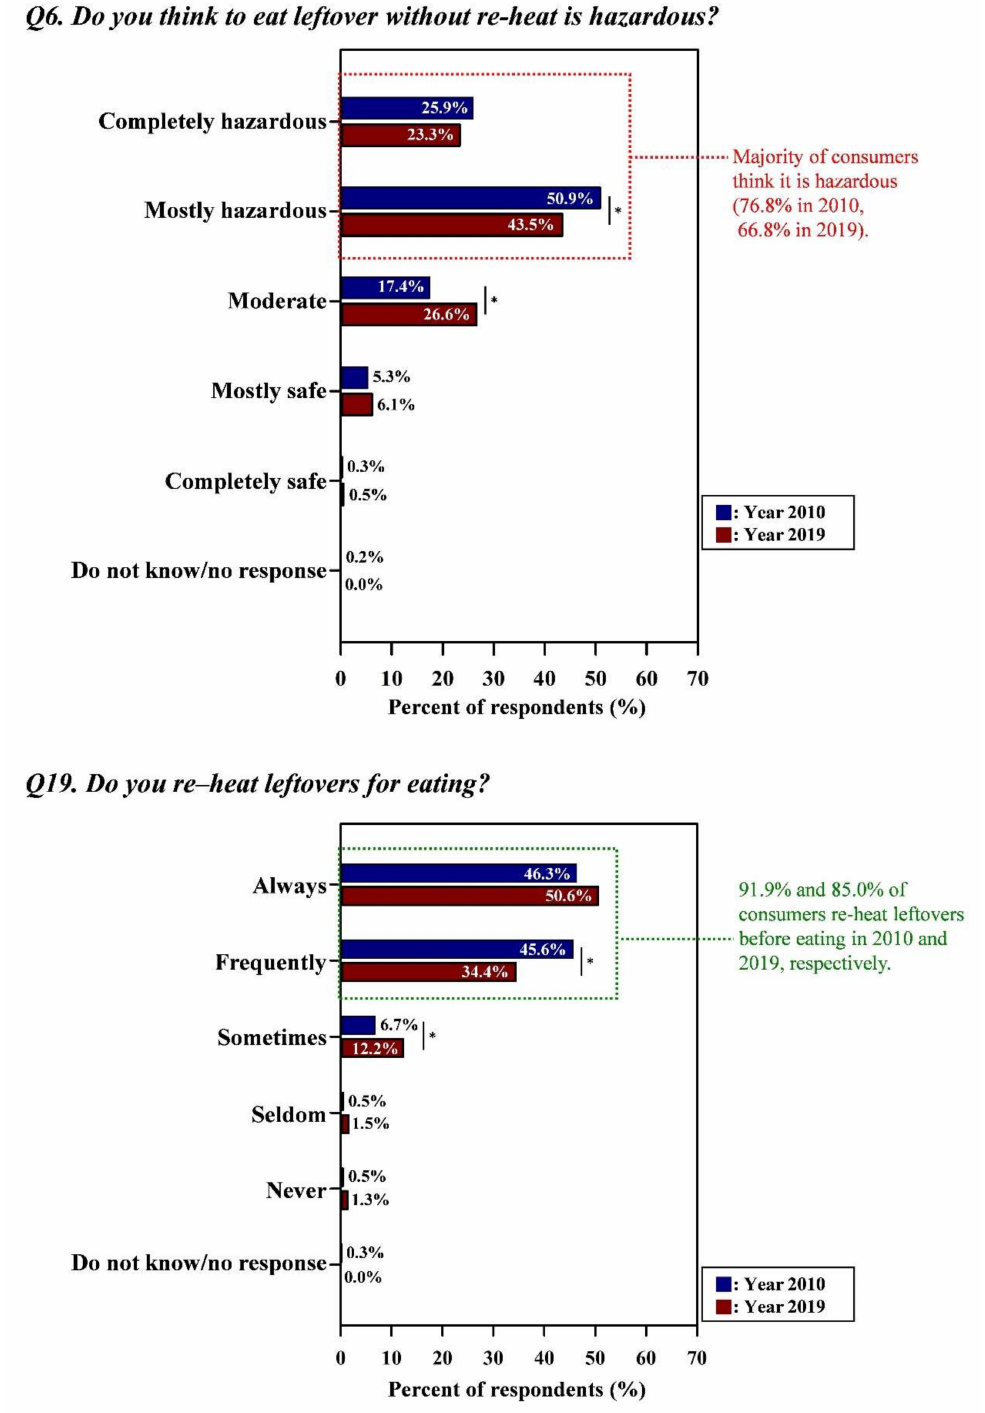
Figure 6. Proper behaviors of consumers in accordance with their perceptions regarding reheating leftovers. Asterisk (*) indicated between graphs means the significant di ff erences of responses (the Kruskal–Wallis test; p < 0.05) in each answer option from Year 2010 and Year 2019. Green letters indicated the proper risk perceptions (i.e., the correct response in line with conventional food safety guidelines) and behaviors of consumers. All data regarding the percentage of the combined answer options (e.g., Always + Frequently) are provided in Table